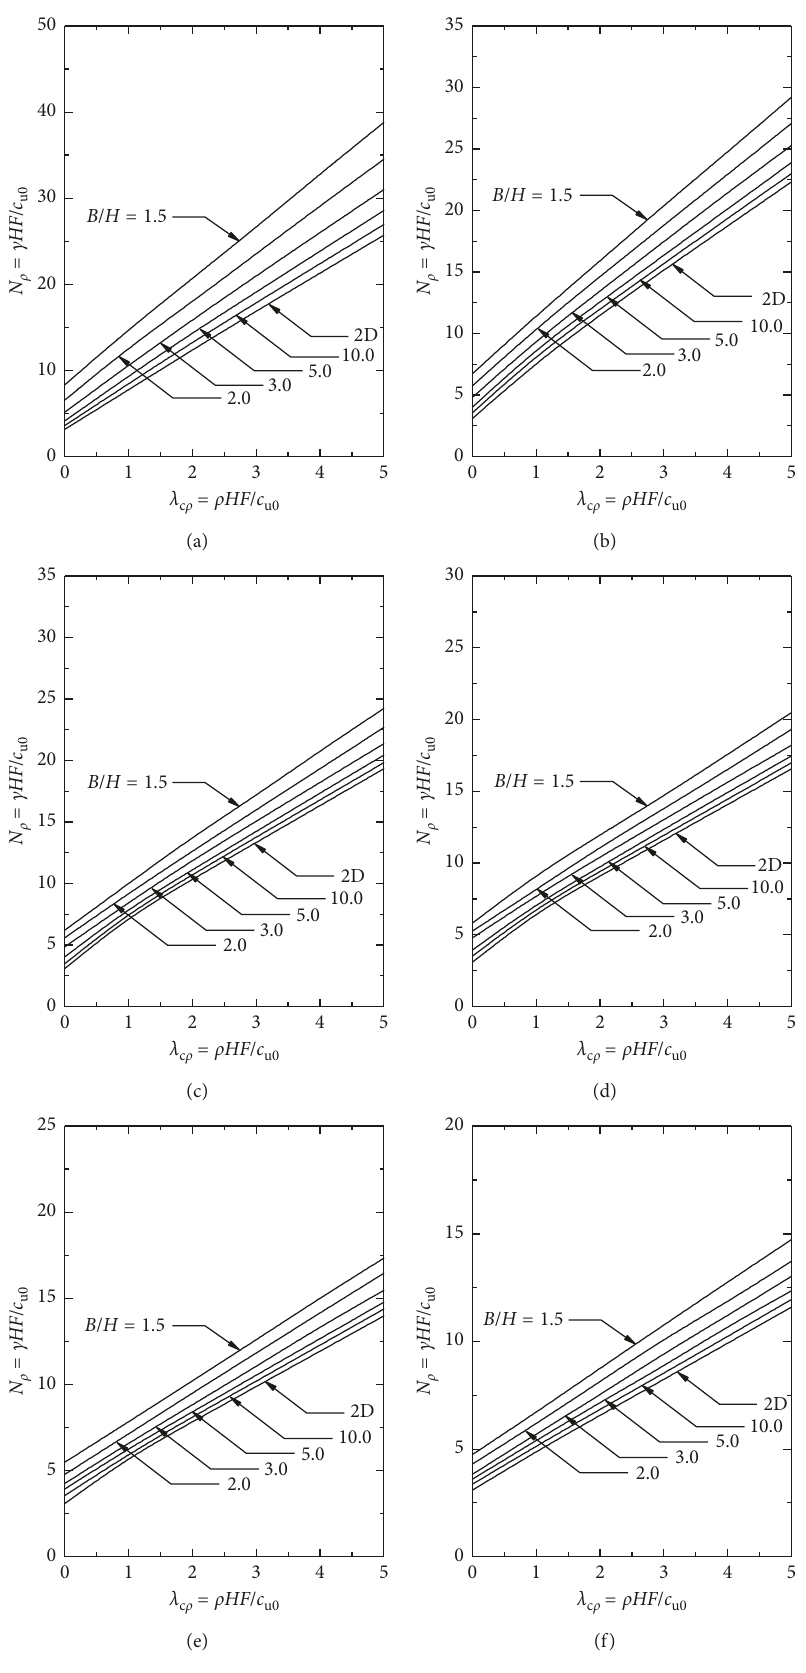
Figure 8: Seismic stability charts for cut slopes with k